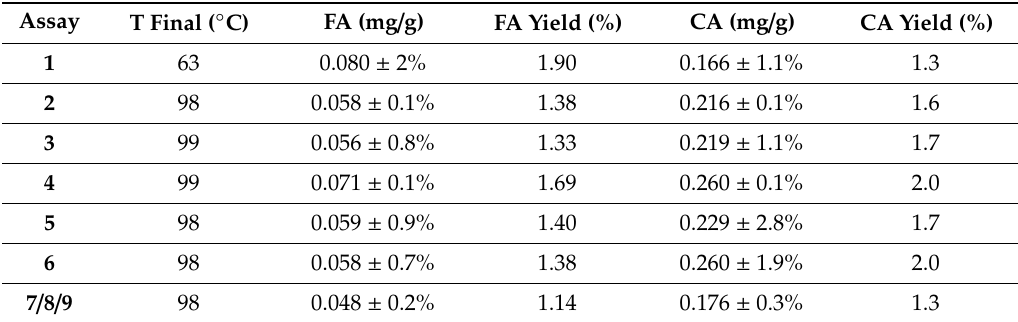
Table 4. Ferulic acid (FA) and coumaric acid (CA) release yields using the experimental design. Yields are expressed in %: mg phenolic acid release / mg initial phenolic acid, mean of duplicate. Assay